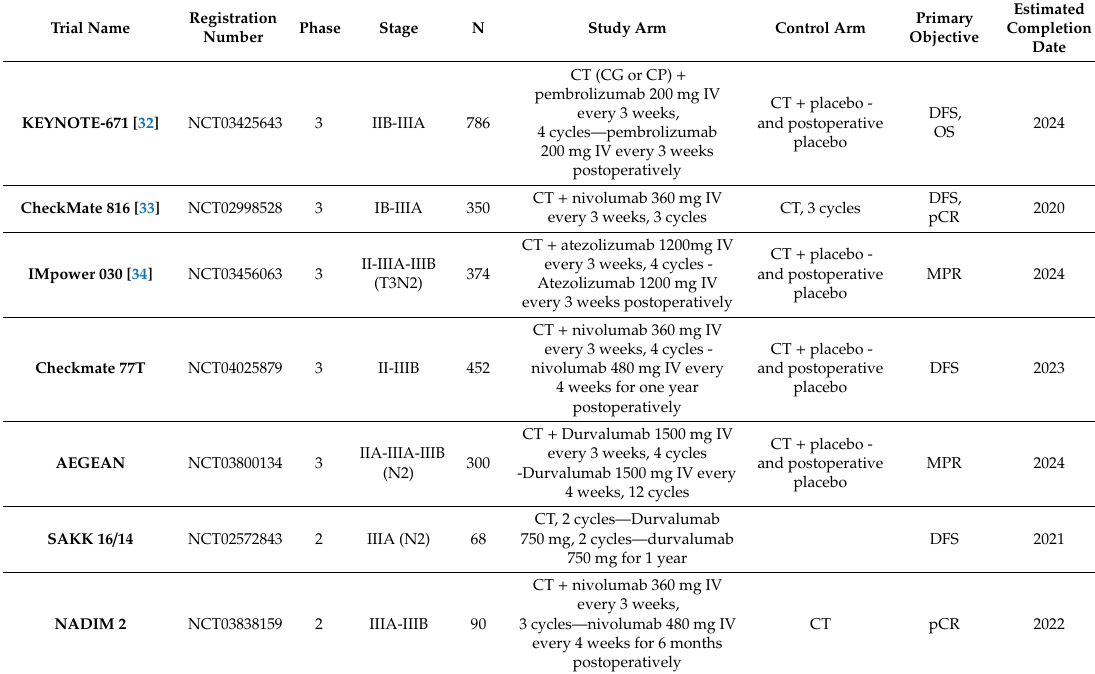
Table 4. Clinical trials ongoing with neo / adjuvant ICI with or without